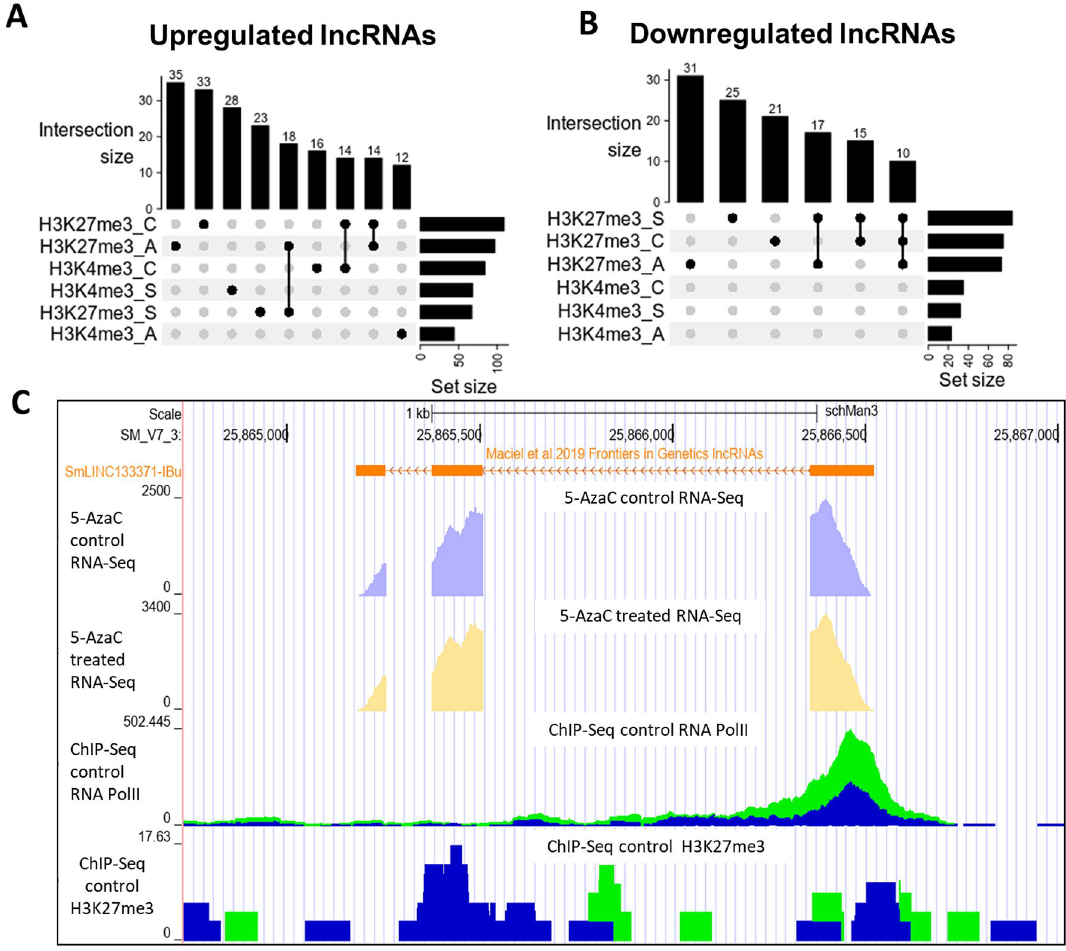
Figure 3. Hundreds of lncRNAs differentially expressed after 5-AzaC exposure in S. mansoni females have histone transcriptional activating or repressive marks at their TSSs. The UpSet intersection diagram shows the number of S. mansoni lncRNAs differentially expressed after 5-AzaC exposure (y-axis) that have been detected in each of the intersection sets, indicated by the connected points in the lower part of the plot, as having the H3K4me3 transcriptional activating marks and/or the H3K27me3 repressive marks within 1 kb (upstream or downstream) from their TSSs. Six histone mark datasets indicated at the bottom left were analyzed: H3K4me3_A in adults, H3K4me3_C in cercariae, H3K4me3_S in schistosomula, H3K27me3_A in adults, H3K27me3_S in schistosomula, and H3K27me3_C in cercariae, and each set size horizontal black bar represents the number of lncRNAs that contain the indicated histone mark at the indicated stage. The top enriched intersection sets are shown for the 5-AzaC upregulated ( A ) and downregulated ( B ) lncRNAs; all intersection sets and the lists of lncRNAs in each intersection set are shown in Supplementary Table S5, S6. ( C ) Snapshot of a S. mansoni genome browser image (www.schis tosom a.usp.br), showing a region spanning 3 kb on chromosome 3, where the SmLINC133371-IBu is located. The orange track (top) represents lncRNAs from S. mansoni published by Maciel et al. 31 . Below the orange lncRNAs track, two other tracks show RNA-Seq data from control (light purple) or 5-AzaC treated S. mansoni females (light yellow). Below, two ChIP-Seq tracks are shown: RNA Polymerase II ChIP-Seq (ChIP-Seq Control RNA Pol II) and H3K27me3 histone mark ChIP-Seq (ChIP-Seq Control H3K27me3). The green and blue colours at the two ChIP-Seq tracks at the bottom represent each of two experimental biological